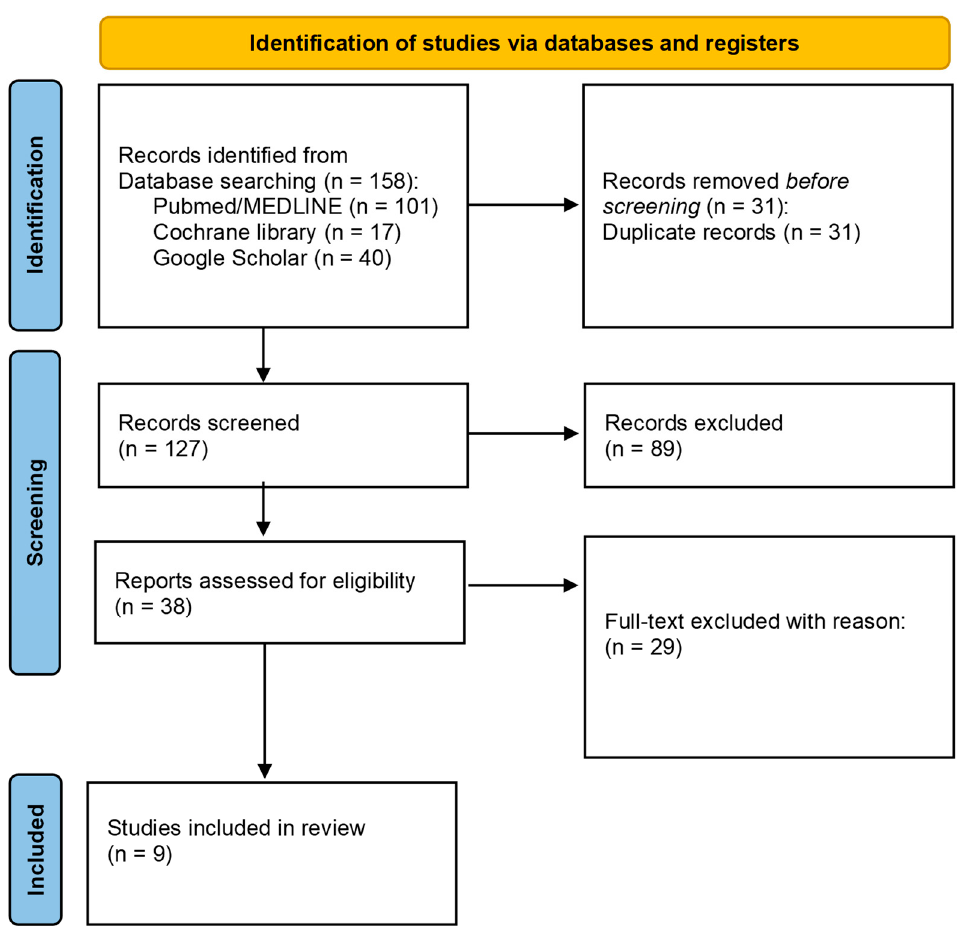
Figure 1. Preferred reporting of systematic reviews and meta-analyses flow diagram related to bibliographic research and study selection.